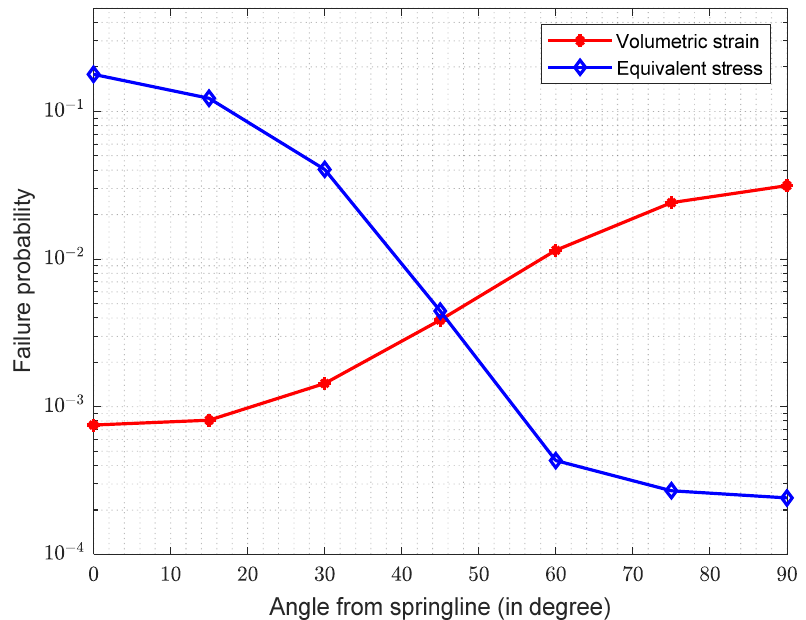
Figure 5. Failure probability of the two liners at different inclined angles with respect to the spring ‐ line.